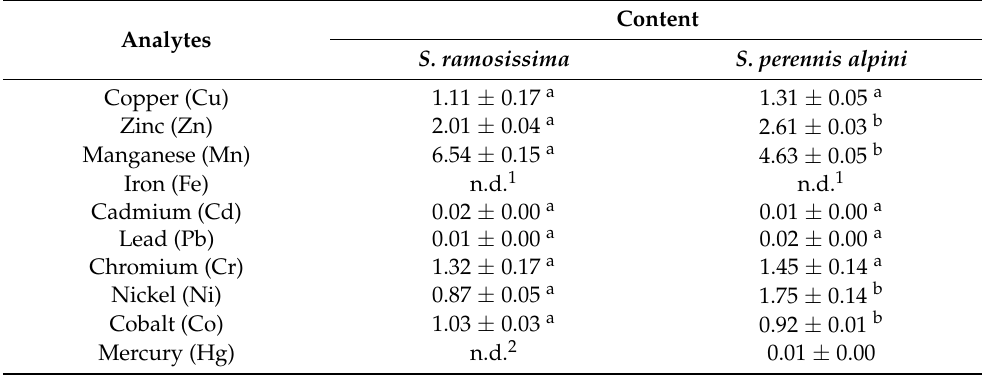
Table 8. Heavy metals contamination (mg/Kg fw) in Salicornia ramosissima and Sarcocornia perennis alpini (mean ± SD; n = 3).